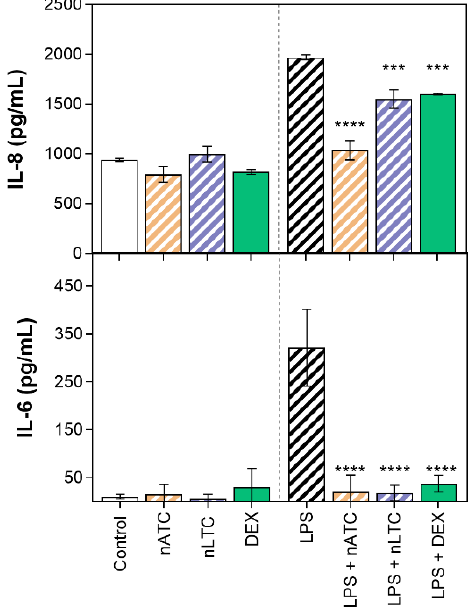
Figure 13. Release of pro-inflammatory cytokines from A549 ALI upon CUR nanovesicles nebulization. Values were analysed using a one-way ANOVA compared with cells activated with LPS, *** p < 0.001; **** p < 0.0001.